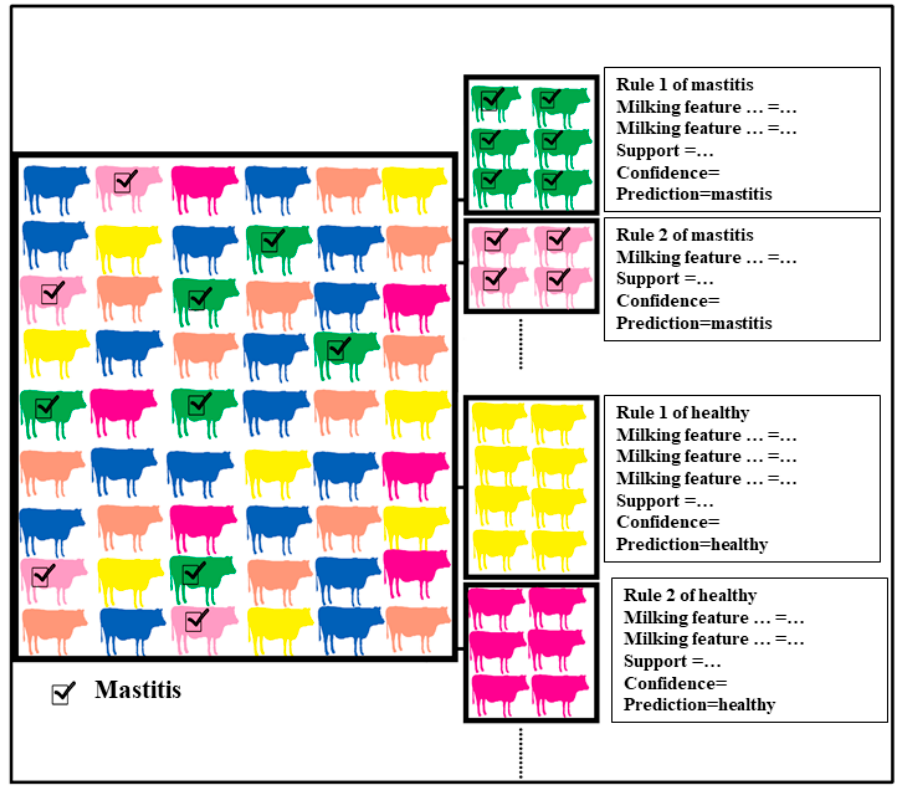
Figure 2. Classification based on associations is a high performing and robust classifier that integrates the classification algorithm with the association rule mining algorithm to deal with data heterogeneity. Classification based on associations finds homogenous groups within heterogenous data, based on minimum support. Then, classifier applies discriminative rules with high confidence in each homogenous group.